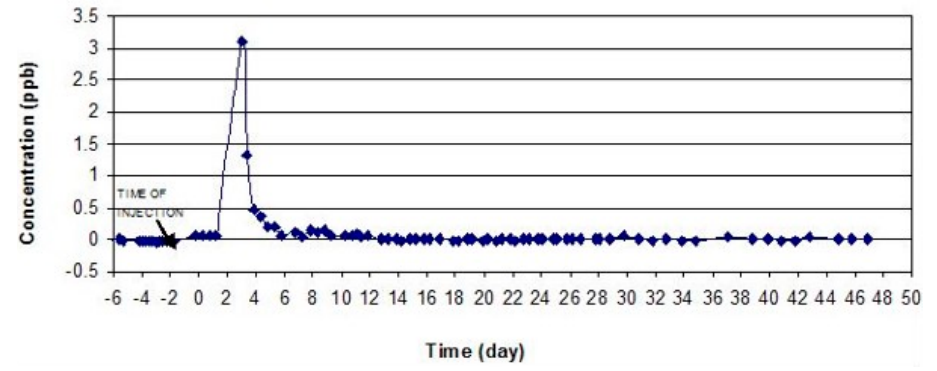
Figure 6. Diagram of uranine concentrations at the Chenar spring.